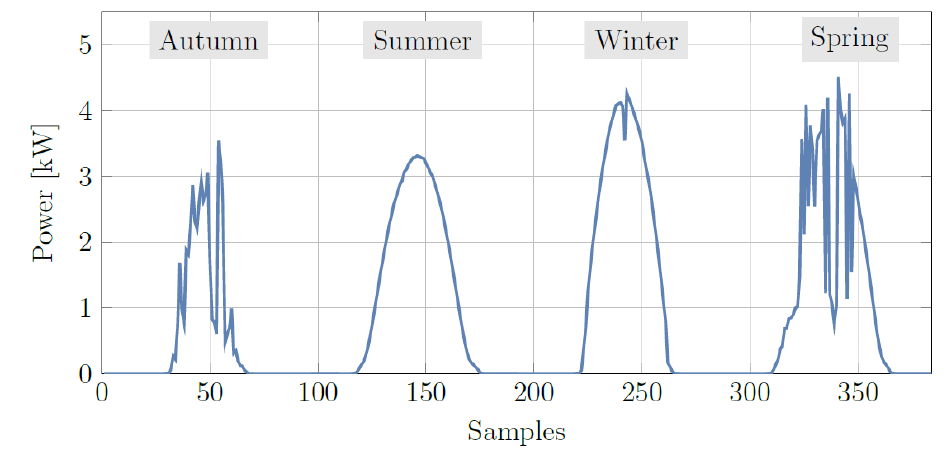
Figure 12. ANN target referred to, from left to right, an autumn, summer, winter and spring